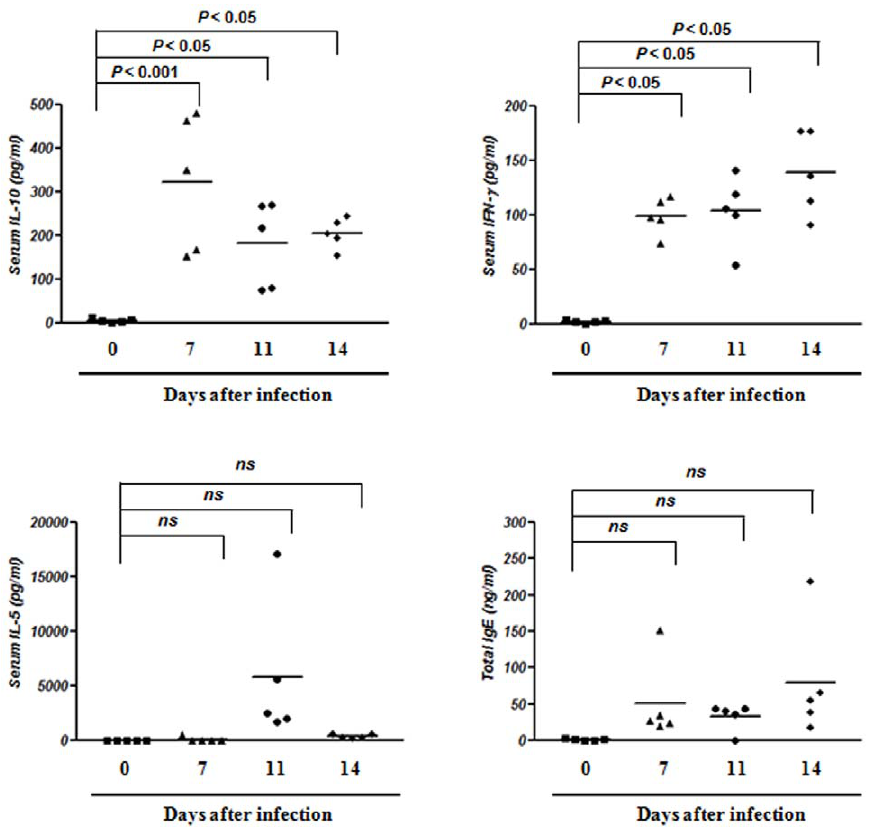
Figure 3. B.microti infection increases the levels of IL-10 and IFN- c , but not IL-5 and total IgE, in serum. Blood samples of uninfected and infected mice were obtained by cardiac puncture. Then ELISA was performed to measure the levels of IFN- c , IL-10, IL-5, and IgE in the serum. Each symbol represents one mouse; horizontal bar indicate the calculated me dian. IL-10 and IFN- c production were increased significantly in infected mice compared to levels in uninfected mice. Data represent the mean 6 the standard deviation of five mice per group. * P , 0.05 and ** P , 0.001 indicates statistical significance compared to the uninfected control group. ns, not statistically significant. All results represent at least three independent experiments with five mice in each group.